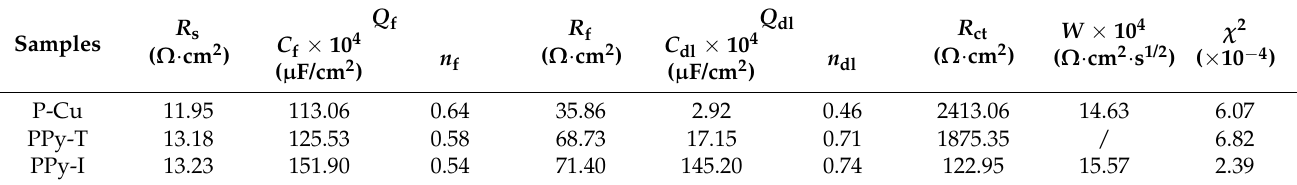
Table 3. Impedance parameters for passivated copper and PPy-T- and PPy-I-coated copper specimens after 24 h immersion in ASW at 298